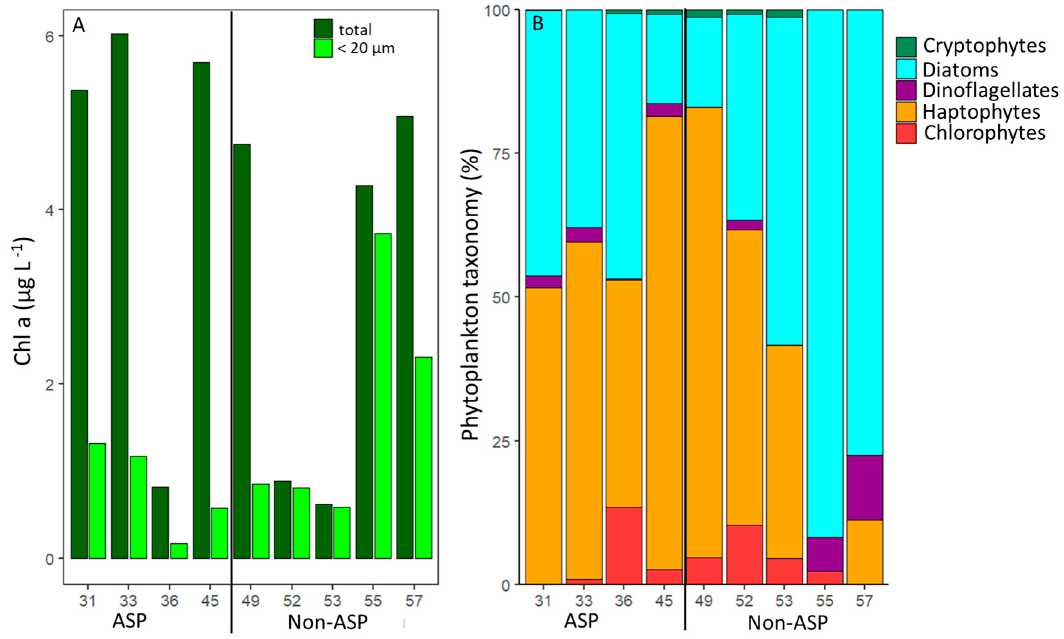
Figure 2. Chlorophyll a concentrations and taxonomic composition of the phytoplankton. ( A ) total and <20 µ m Chl a concentrations. ( B ) Phytoplankton community composition for <20 µ m size fraction. Stations 31–45 lie within the Amundsen Sea Polynya (ASP) and stations 49–57 outside of it. Total phytoplankton abundance was highest at stations 49 and 53 (both outside the ASP, 8598 and 8595 cells mL − 1 , respectively; Figure 3) and lowest at station 36 (753 cells mL − 1 ). In accordance with Chl a data for the <20 µ m phytoplankton size fraction, total phytoplankton abundances (measured by flow cytometry; mostly <20 µ m cell diameter) were significantly higher outside than within the ASP (mean: 6234 ± 2316 vs. 2508 ± 2166 cells mL − 1 ; Table 3, test 5). Although Phyto 1, 4, and 8 (Figure 3) were only found outside of the ASP, their abundances (average of 67 ± 201, 22 ± 66, and 5 ± 11 cells mL − 1 , n = 1, 1, and 2, respectively) were not high enough to explain the difference in total phytoplankton abundances within and outside the ASP. No significant correlations were found between phytoplankton abundance and dissolved inorganic nutrients or salinity. The temperature was significantly higher inside compared to outside the ASP (mean: − 0.8 ± 0.5 vs. − 1.2 ± 0.3 ◦ C; Table 3, test 6). Higher temperatures might lead to higher phytoplankton production [83,84]; however, the phytoplankton gross growth rates were not significantly different between ASP and non- ASP stations (Table S8). Furthermore, no significant correlation was observed between phytoplankton abundance and temperature, suggesting that the 0.4 ◦ C difference in average temperature was not the (main) driver of phytoplankton abundance. The lower phytoplankton numbers within the ASP might thus be driven by the significantly higher total loss rates of the phytoplankton inside compared to outside the ASP (mean: 0.62 ± 0.27 d − 1 versus 0.39 ± 0.27; Table 3, test 7 and see Section